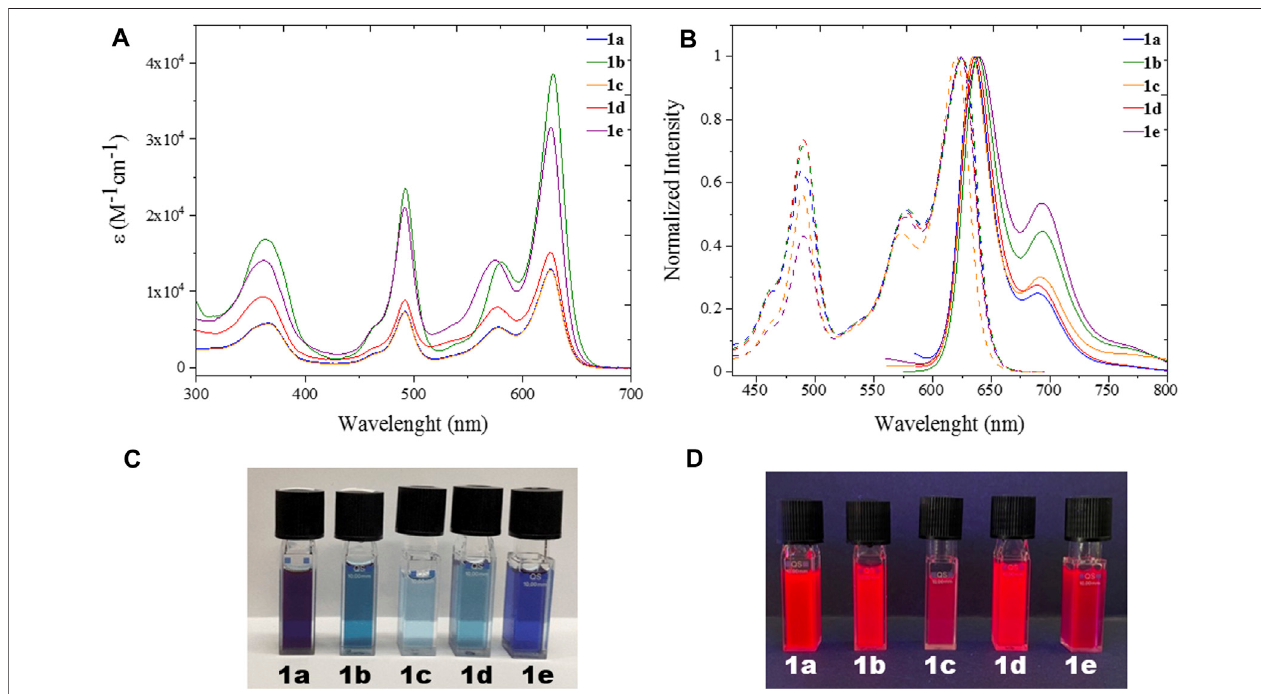
FIGURE 2 | UV (A) Uv/Vis absorption spectra with molar absorptivity coef fi cient ( Ɛ ) and (B) excitation and emission spectra of heteroleptic complexes 1a-e ( λ exc (cid:1) 570 nm) in spectroscopic DMSO; (C) Pictures of 1a-e in dimethyl sulfoxide solution under ambient (top) and (D) UV (bottom) light.